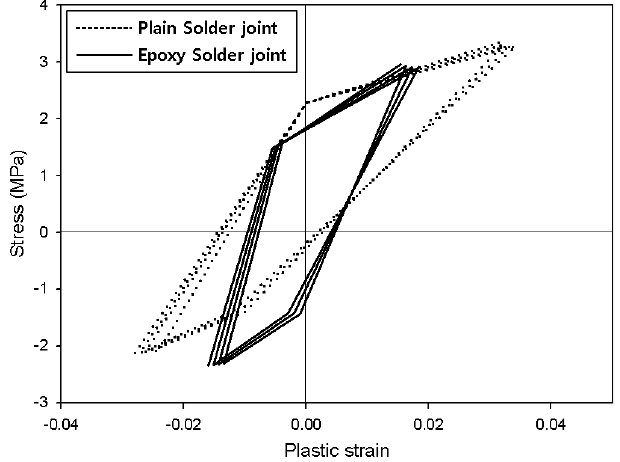
Figure 6. Plastic strain-stress curves for SAC305 solder joints.